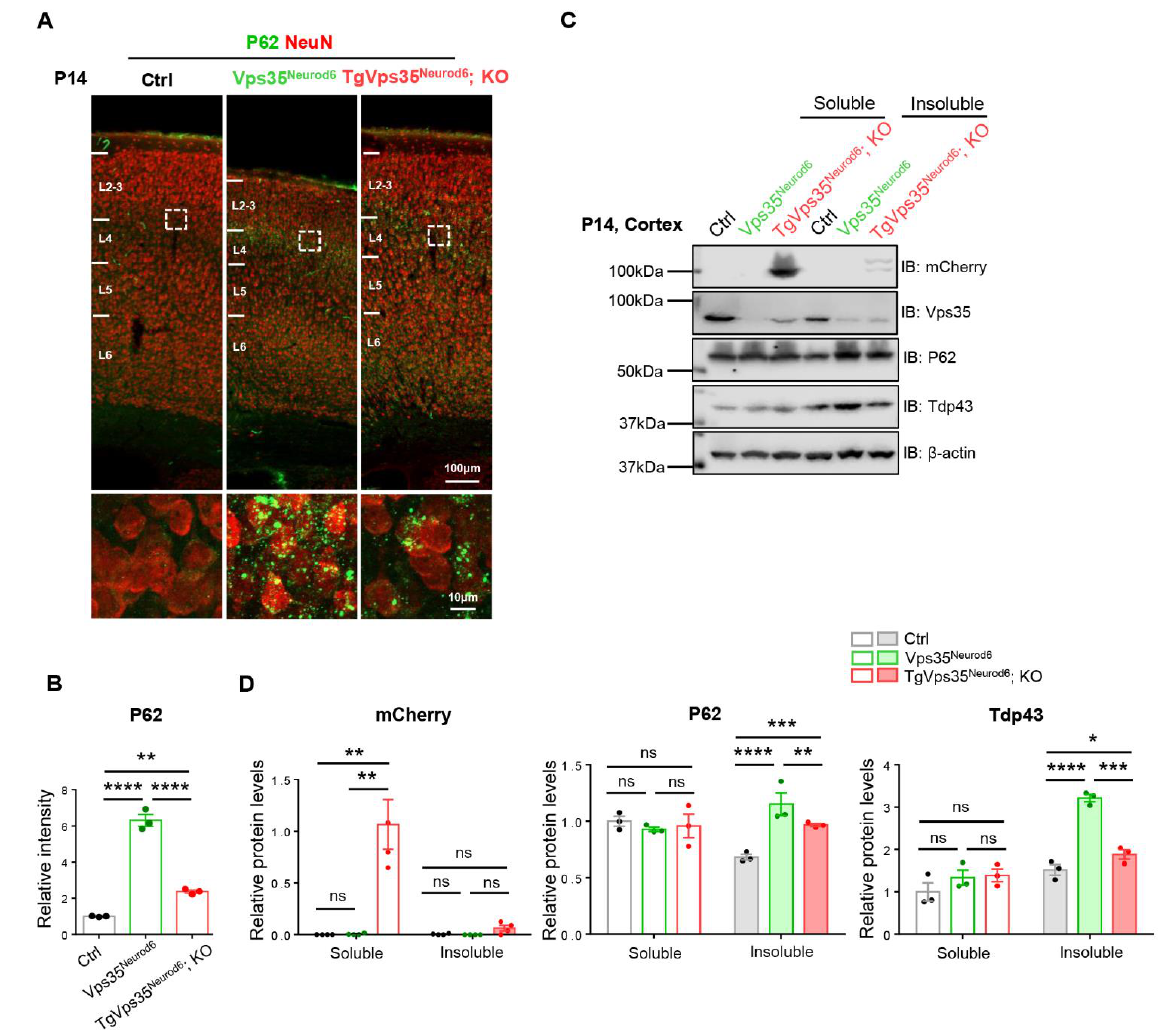
Figure 4. Partial recovery of FTD (frontotemporal dementia)-like neuropathology in Vps35 Neurod6 neocortex. ( A ) Representa- tive images of co-immunostaining analysis with antibodies against P62 (green) and NeuN (red) of P14 cortical sections. ( B ) Quantification analysis of immunofluorescence of from A ( n = 3 animals per genotype; one-way ANOVA with Tukey’s multiple-comparison test). ( C ) Western blot analyses of soluble (by 1% TritonX-100) and insoluble fractions (by 7 M Urea, 2 M Thiourea, 4% CHAPS) of homogenates of P14 control, Vps35 Neurod6 and TgVps35 Neurod6 ; KO mice using indicated antibodies. ( D ) Quantification analysis of relative protein expression levels from C ( n = 3 animals per genotype; one-way ANOVA with Tukey’s multiple-comparison test). Scale bars as indicated in each panel. Individual data points were shown as dots with group mean ± S.E.M; * p < 0.05; ** p < 0.01; *** p < 0.001; **** p < 0.0001; n.s.: Not